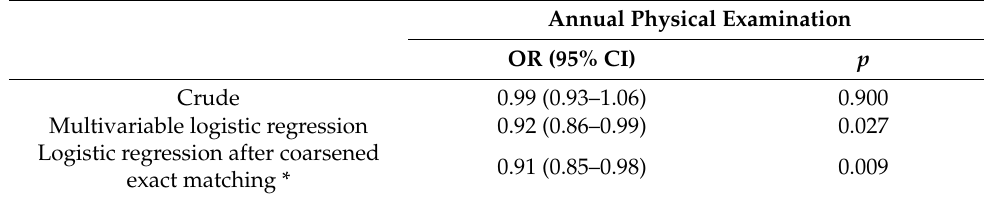
Table 2. Association of migration with physical examination.